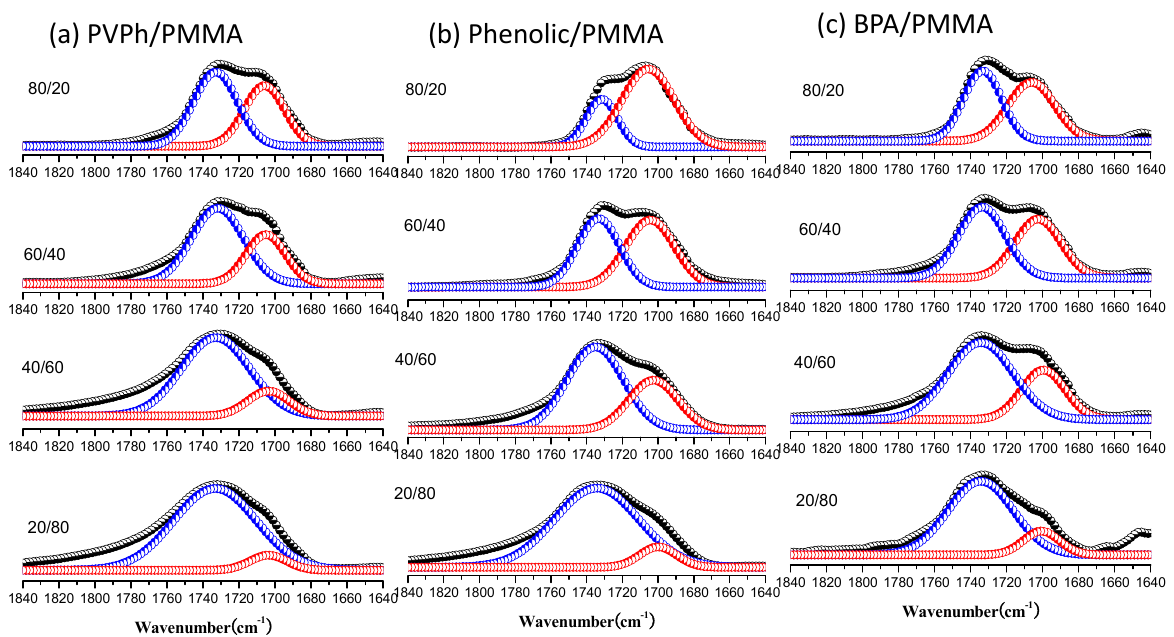
Figure 9. Deconstructed models of the C=O stretching bands (in Figure 8) with respect to the weight percentages of ( a ) PVPh/PMMA, ( b ) phenolic/PMMA, and ( c ) BPA/PMMA blends at various compositions.